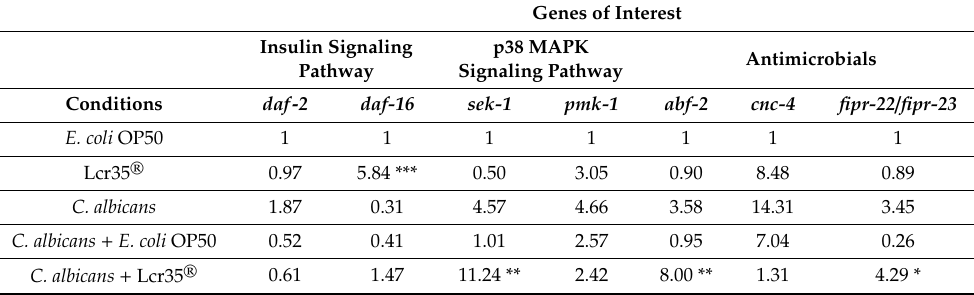
Table 2. Relative expression of C. elegans genes of interest in presence of Lcr35 ® and C. albicans in pure or in sequential cultures in comparison with the control condition E. coli OP50 (alone). Genes were considered di ff erentially expressed when the p -value was lower than 0.05 (*), 0.01 (**), or 0.001 (***) according to Fisher’s LSD test, and simultaneously when the expression change was of at least 2 times or 0.5